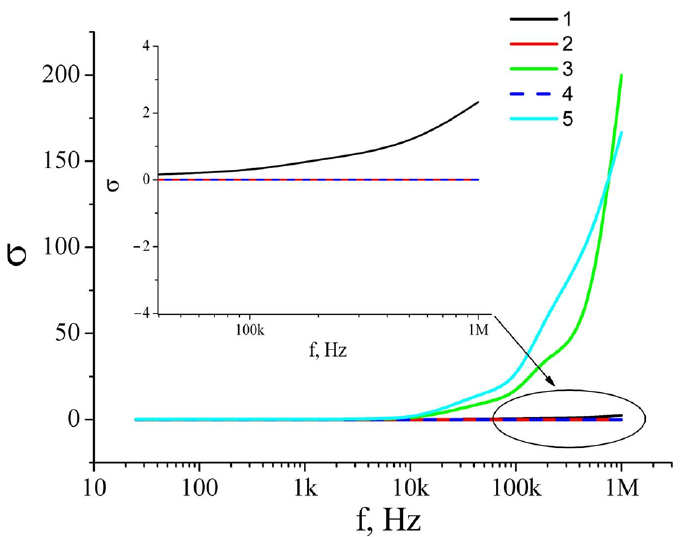
Figure 11. Dependences of films conductivity on the frequency of applied voltage: ( 1 ) TiO 2 layer; ( 2 ) two layers: TiO 2 /Ag_NW; ( 3 ) two layers: TiO 2 /Ag_NW_MW; ( 4 ) three layers: TiO 2 /Ag_NW/TiO 2 ; ( 5 ) three layers: TiO 2 /Ag_NW_MW/TiO 2 .